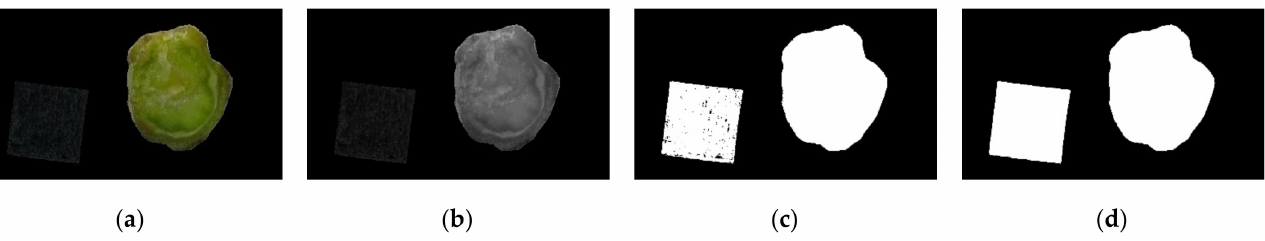
Figure 5. The image processing steps: ( a ) Masks and bitwise operation; ( b ) Grayscale; ( c ) Binarization; ( d ) Closing operation.